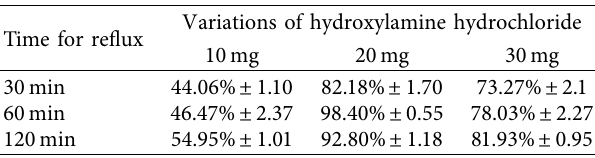
Figure 1: Result of screening herbal medicine with TLC compared with standard, control positive ( K +), and control negative ( K − ). Table 1: Optimization of conditions and time for the formation of the dexamethasone-hydroxylamine